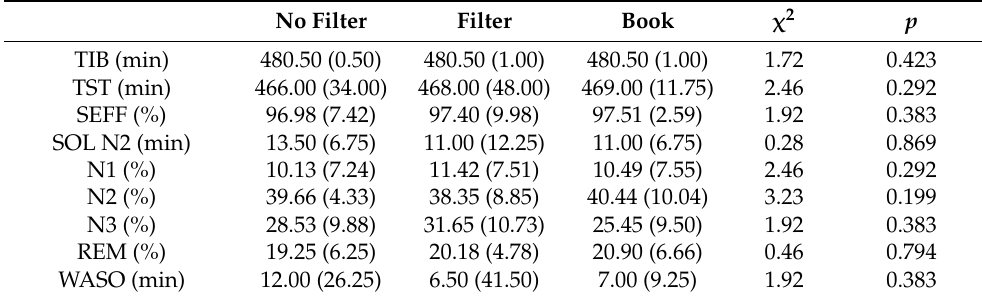
Table 1. Median and interquartile ranges (IQR) for whole night sleep architecture. Chi-Square test statistics and significance levels are derived from non-parametric Friedman tests ( N = 13).